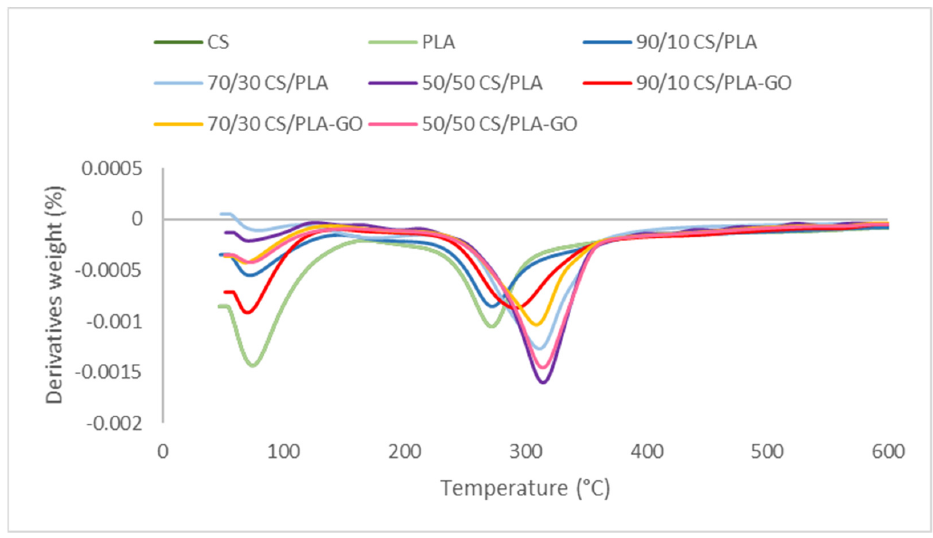
Figure 5. DTG thermograms of CS, PLA and CS/PLA with and without GO composites.